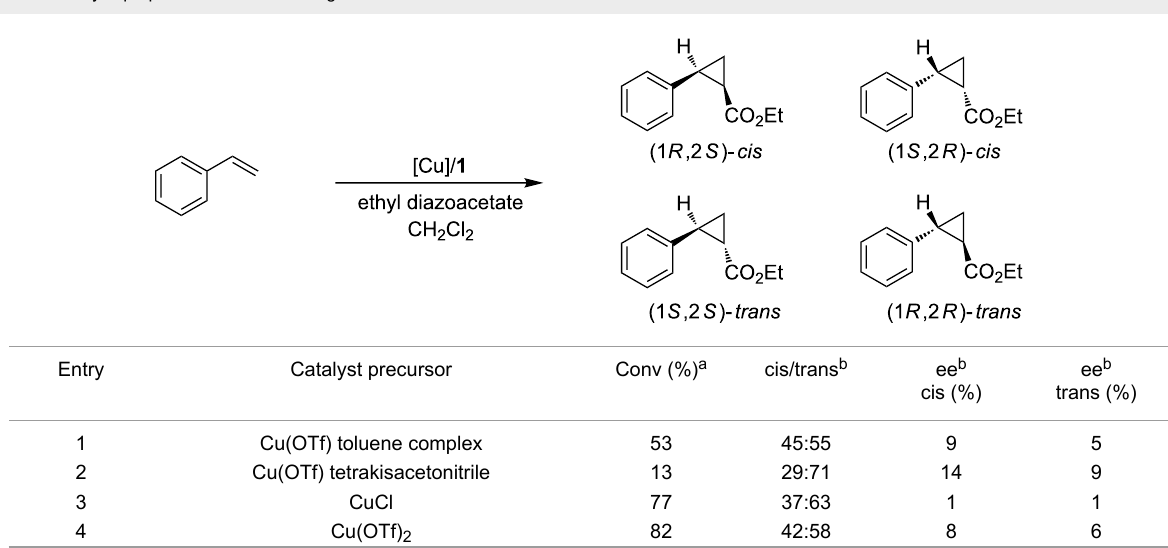
Table 1: Cyclopropanation with cubane ligand 1 .